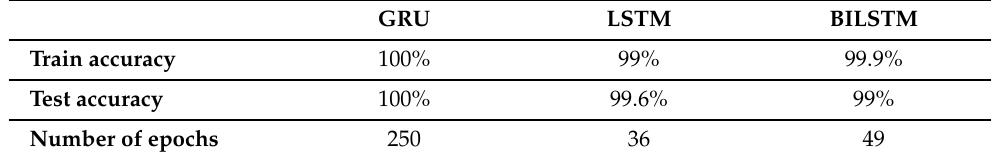
Figure 10. The stages of extracting the keypoints from the frame (including face keypoints). Table 3. Models accuracy with face